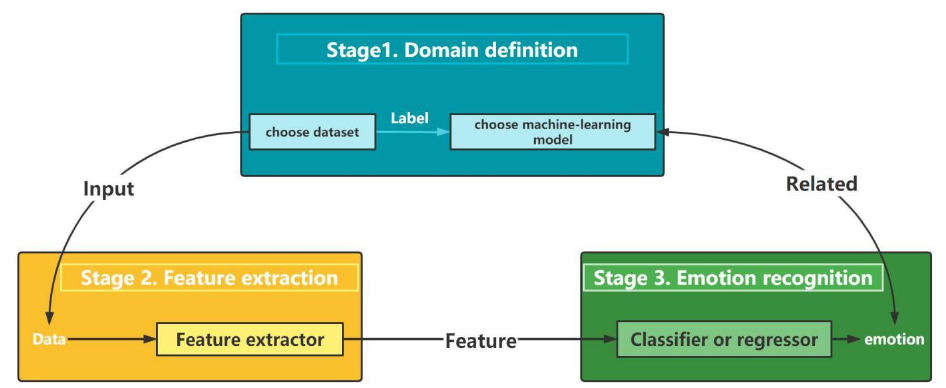
Figure 2. Three steps of the proposed method.